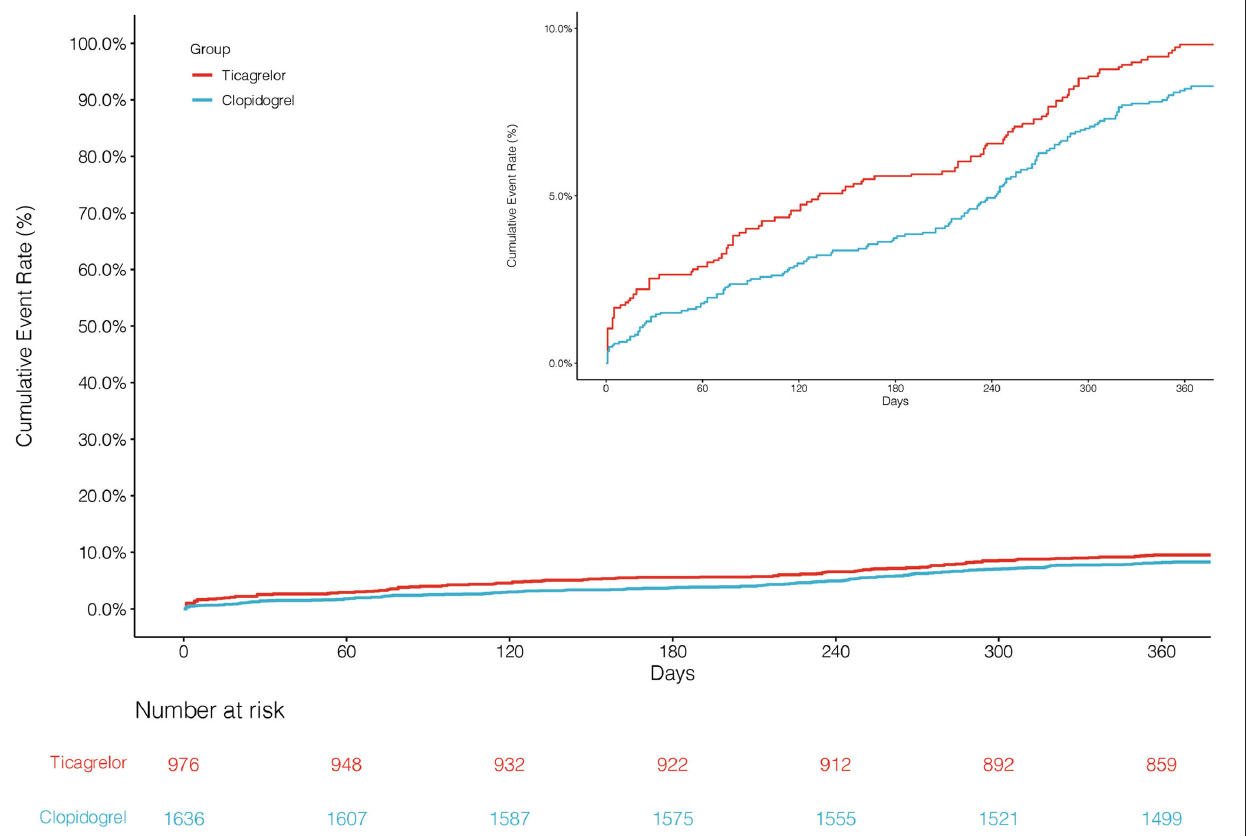
FIGURE 2 | Cumulative incidence of NACCEs after inverse probability of treatment weights.